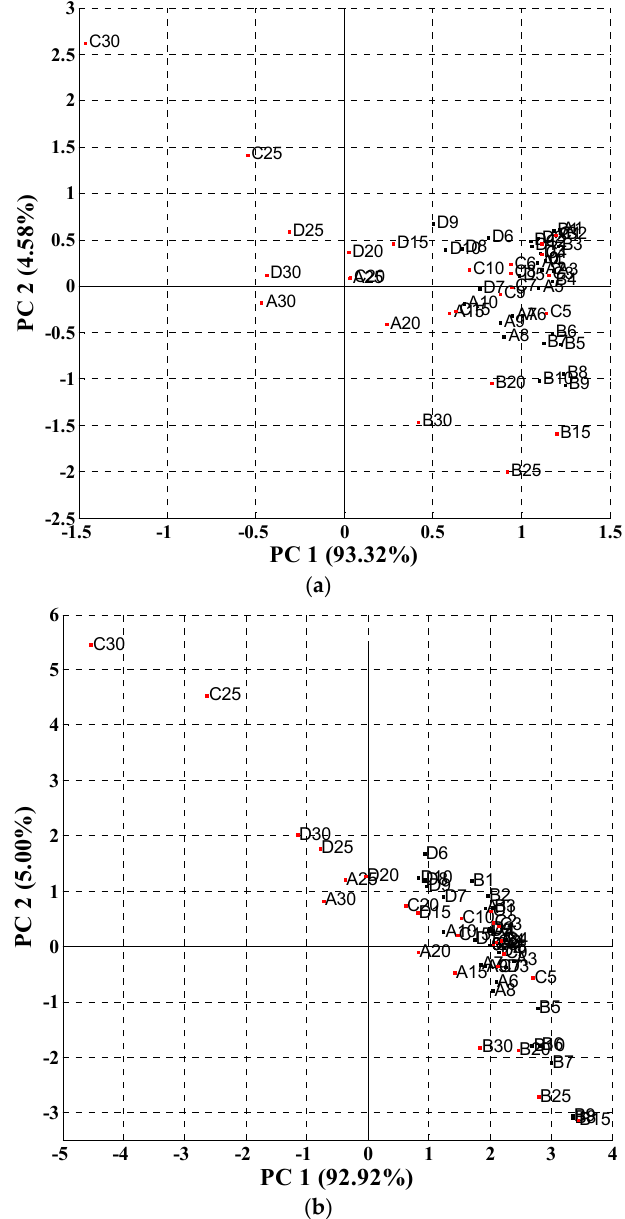
Figure 4. Score plots of the first two PCs of PCA. Samples are named according to the soy types (A = Arconet, B = toasted soy grits, C = Profam, D = TVP, 16 samples for each soy type) and soy contents (unit: %, from 0, i.e., pure beef, to 100, i.e., pure soy products). ( a ) PCA for dispersive spectral data; ( b ) PCA for FT-NIR data, PC: principal component; PCA: principal component analysis.